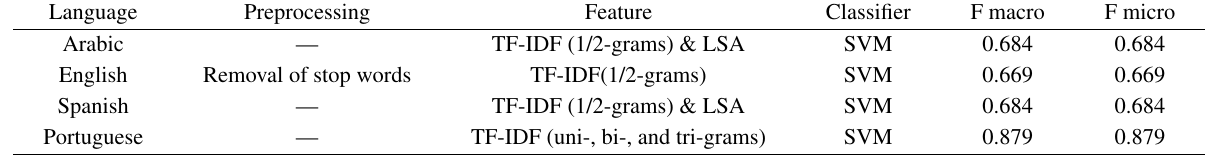
Table 10 Language variety classification results for loose classification [48]